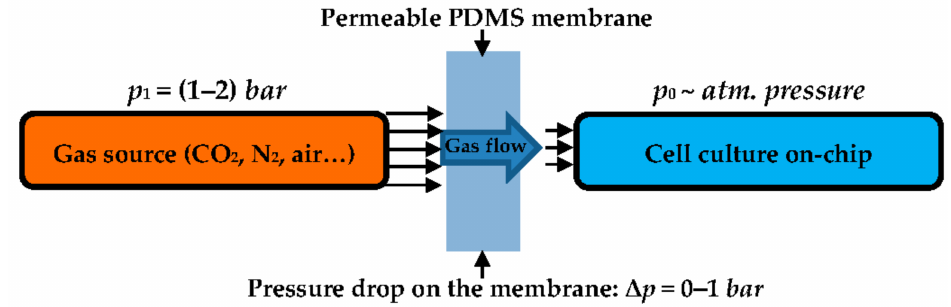
Figure 1. Concept of flow regulation in the 3D printed membrane-based gas microflow regulator. PDMS: